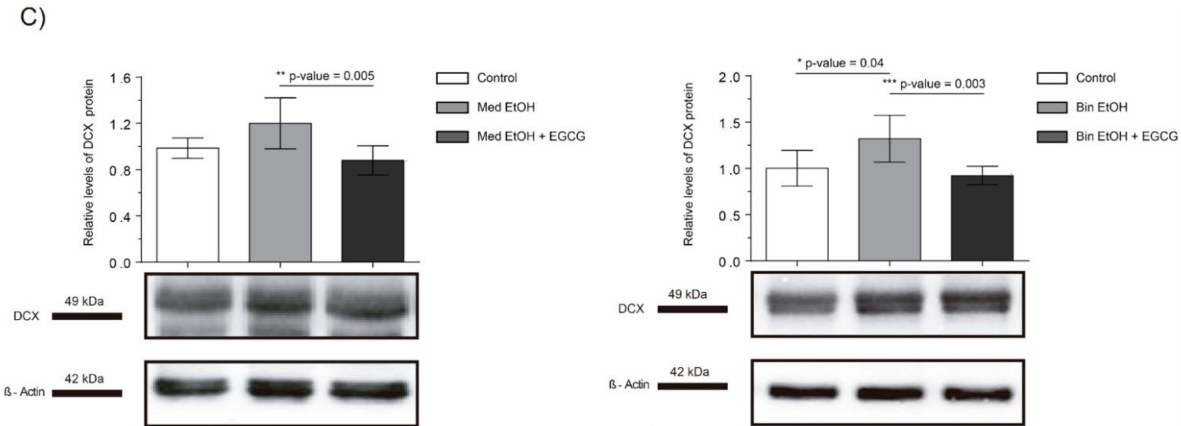
Figure 7. Representative doublecortin (DCX) immunostaining in the hippocampus ( A ) and cerebellum ( B ), and Western blot DCX protein analysis in whole brain lysed samples ( C ) for PAE and EGCG treatment. ( A ) DCX + cell quantification in whole sections of the dentate gyrus using a 10 × objective lens. ( B ) DCX + cell quantification in sections of the cerebellum in two different microscopic fields using a 40 × objective lens. ( C ) Representative Western blot of DCX expression observed in all analyzed samples for the various experimental conditions. Protein levels were normalized using α -tubulin as load control. Arbitrary units express “fold change”. At least five samples from different litters were used from each group. Kruskal–Wallis test (Dunn’s test for multiple comparisons) was performed for inter-group comparisons. Asterisks denote the level of significance: * p -value < 0.05, ** p -value < 0.01. *** p -value < 0.005.